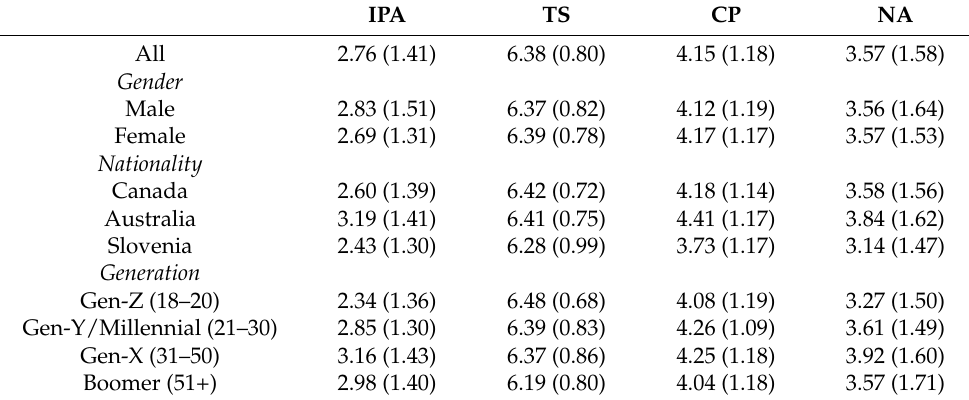
Table 4. Descriptive statistics.